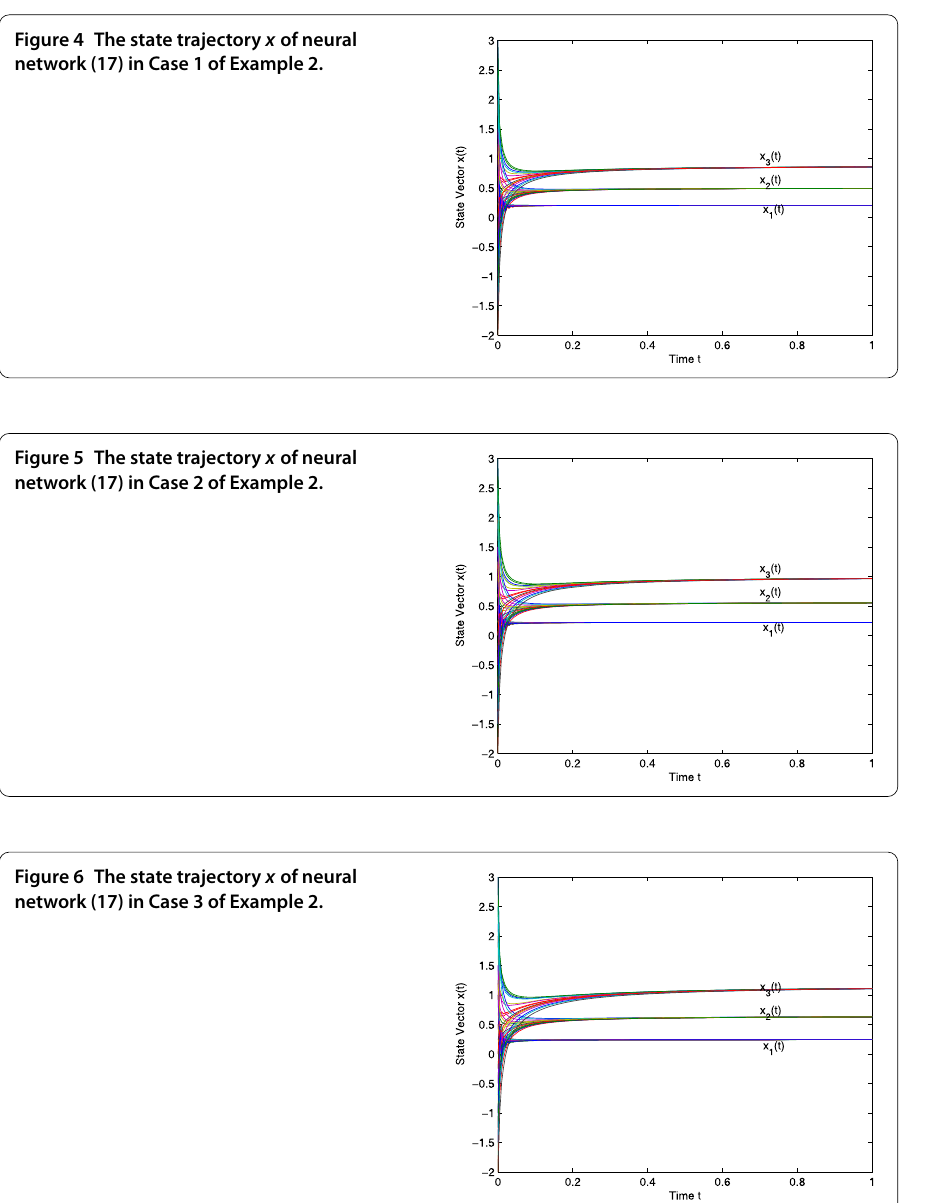
Figure 4 The state trajectory x of neural network (17) in Case 1 of Example 2.